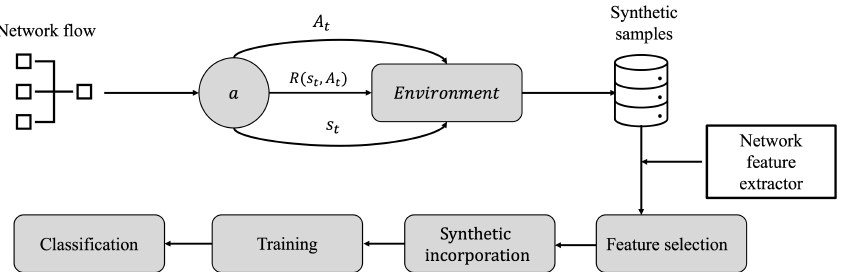
Figure 4. Proposed framework for the generation of synthetic samples of DoS cyber-attacks employing